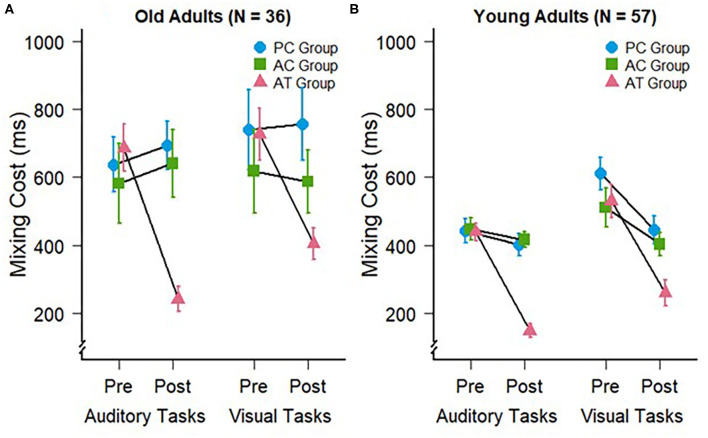
Mixing costs during auditory (trained) and visual (untrained) task switching at pre- and post-test for (A) the old adults of the present study and (B) young adults of a previous study (Kattner et al., 2019). Error bars depict standard errors of the mean.